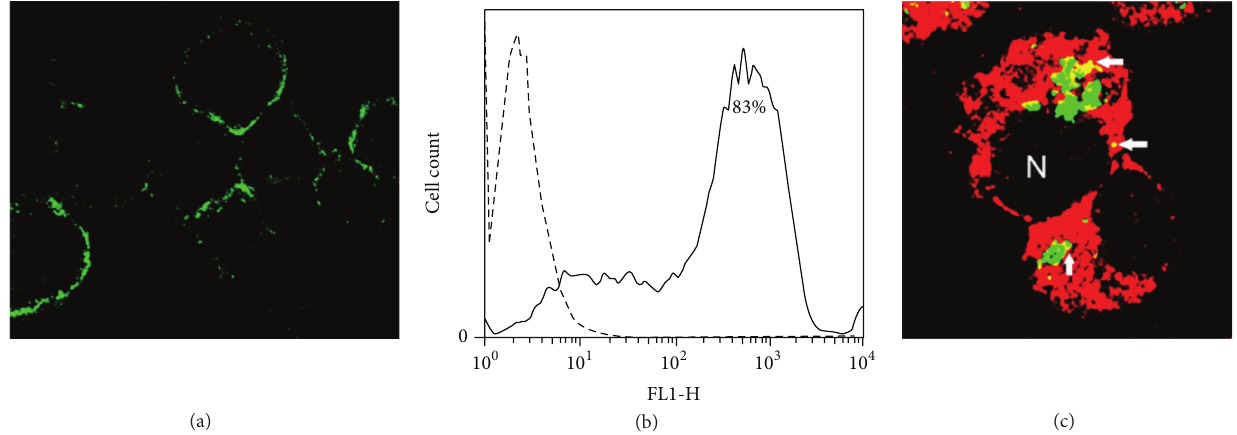
Figure 4: Immunofluorescence demonstration of the role of the mannose receptor in the phagocytosis of apoptotic cells. To determine the expression of the MR on J-774A.1 macrophage-like cells, the cells were incubated with a Cy5-labeled anti-MR antibody. Confocal microscopy revealed patchy membrane fluorescence in many of the cells ((a), original 40x). A representative flow cytometry histogram demonstrated 83% MR expression (b); an isotype control is shown (dashed line). In overlaid confocal microscopy images, the role of the MR in phagocytosis was shown by the yellow fluorescent colocalization (arrows) of the MR (red fluorescence) with apoptotic bodies (green fluorescence) ((c), original